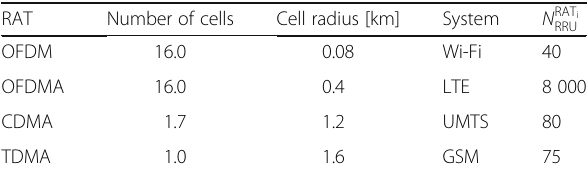
Table 1 Different RAT cell radius Table 2 Network traffic